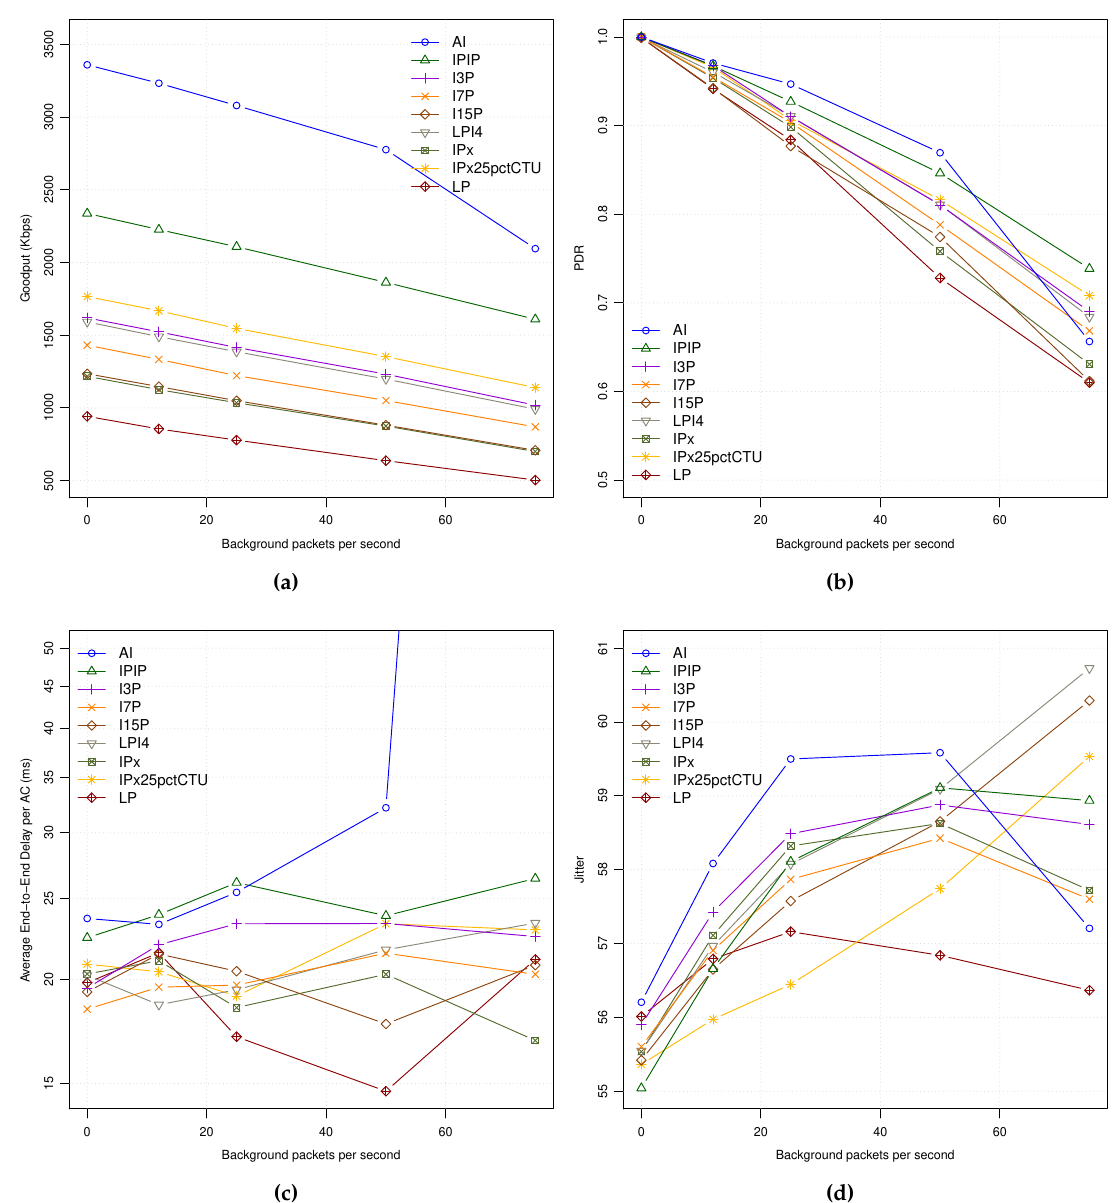
Figure 3. APP statistics for all the encoding modes: ( a ) GP. ( b ) PDR. ( c ) E2E-Delay. ( d )